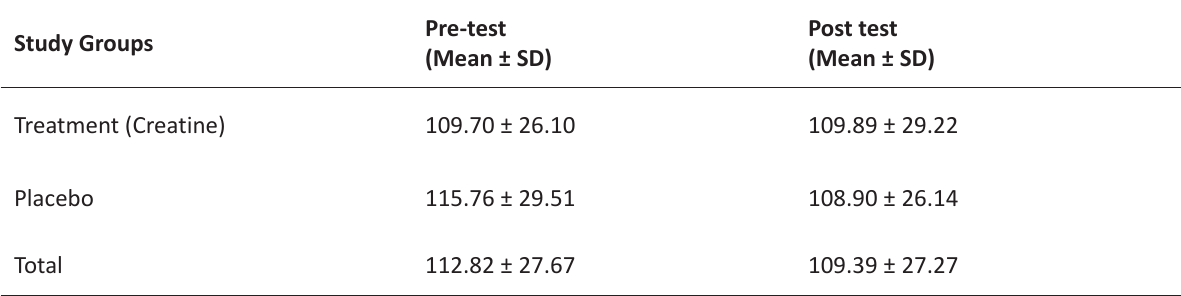
Table 1. Physiologic responses at comparing maximum stroke volume at treatment and placebo